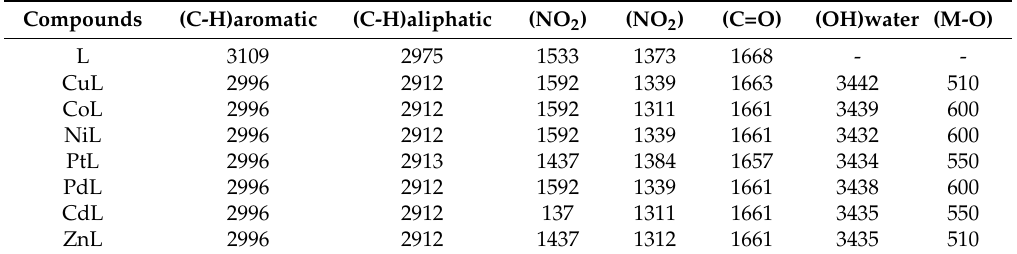
Table 3. The Fourier-transform infrared (FTIR) spectroscopy data of ligand (L) and its metal complexes. Compounds